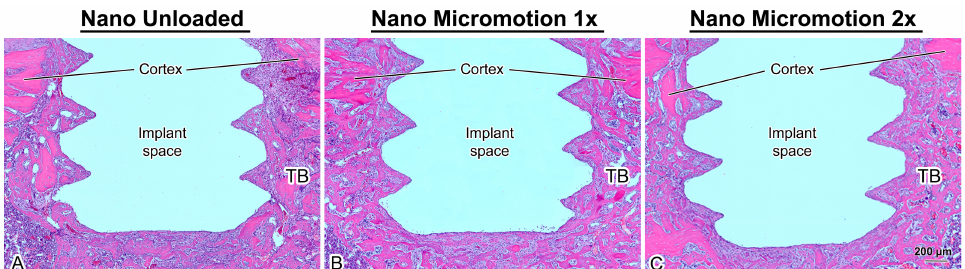
Figure 3. Light microscope images of longitudinally oriented sections stained with hematoxylin and eosin, from ( A ) Nano Unloaded; ( B ) Nano Micromotion 1x and ( C ) Nano Micromotion 2x groups at 7 days post-surgery. New bone forms around the implants in all groups, including between the implant threads. However, signs of disruption of bone healing at the bone–implant interface were noticed in the Nano Micromotion 2x group. TB = trabecular bone in marrow space.